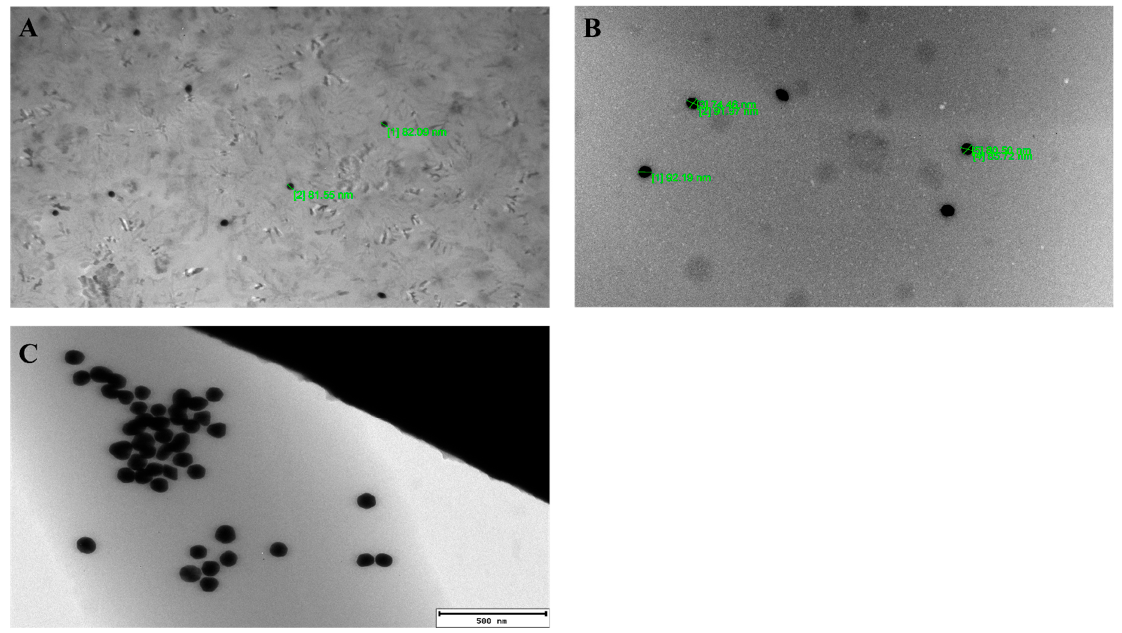
Figure 4. Transmission electron microscopy image of the nanogold particles. ( A ) Nanogold without protein. ( B ) Nanogold coated with scFv D2–5-HT1A protein. ( C ) High-resolution picture of scFv-coated nanogold particles.